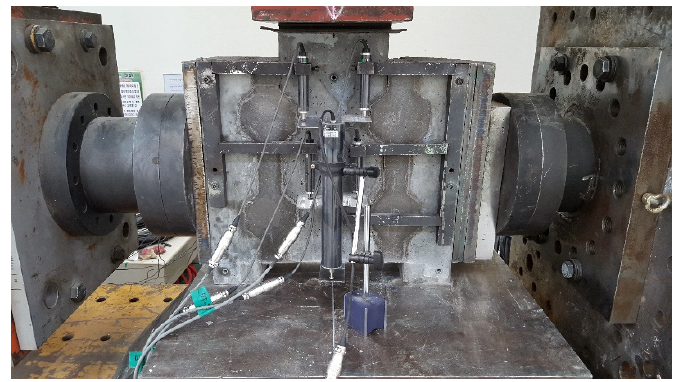
Figure 3. Set-up of push-off test specimens.